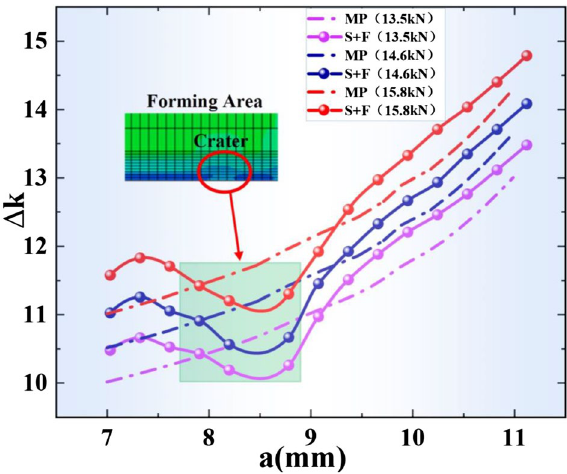
Figure 6. Overall stress intensity factor at different crack